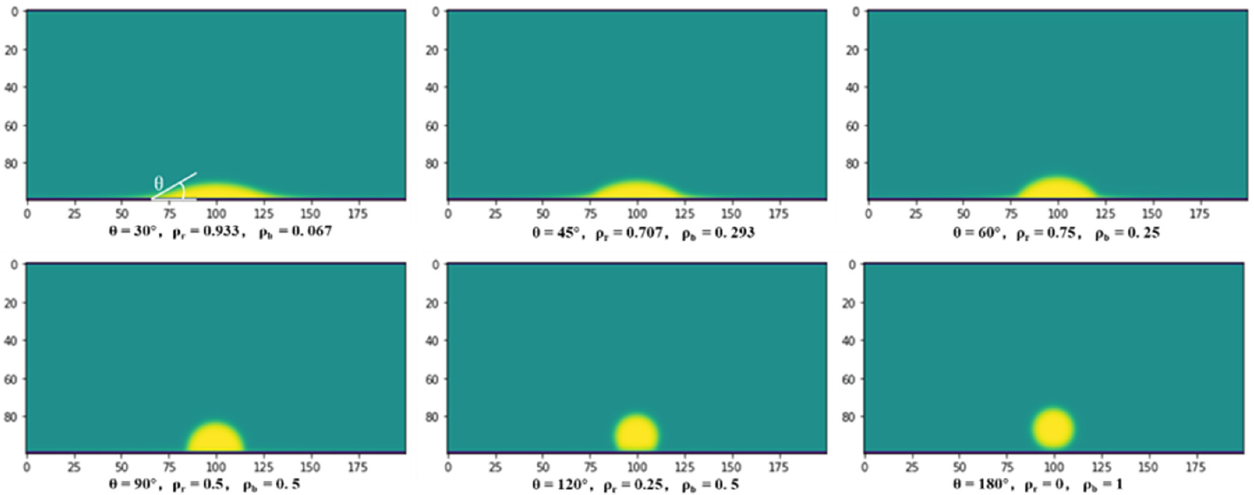
Figure 5. The initial distribution of the two-phase fluid (yellow and green are different phases).